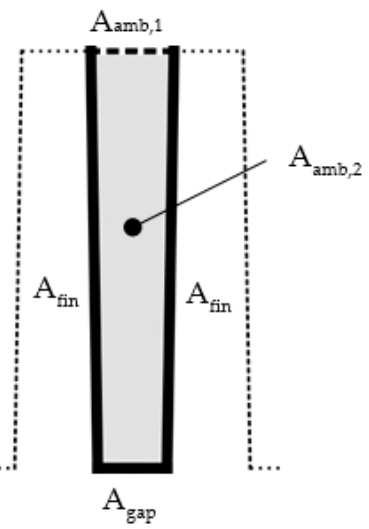
Figure 15. Two-dimensional cut of a simplified fin model used to evaluate the ambient view factor.